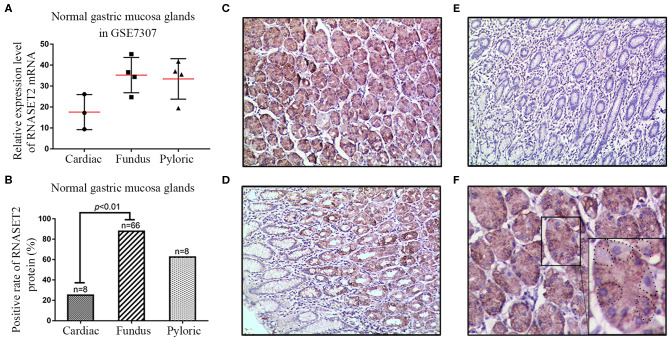
Expression and localization of RNASET2 in different anatomic zones of the stomach. (A) The dataset from GSE7307 showed the relative expression level of RNASET2 mRNA in fundus gland, pyloric gland, and cardiac gland of the normal gastric mucosa tissues. (B) Positive rate of RNASET2 protein in fundus gland, pyloric gland, and cardiac gland of normal gastric mucosa tissues (p < 0.01, Chi-Square and Fisher's exact tests). (C–E) Immunohistochemical staining of RNASET2 protein in fundus gland (C), pyloric gland (D), and cardiac gland (E) of the normal gastric mucosa; DAB staining (brown); nuclear counterstaining (hematoxylin); original magnification, ×100. (F) Representative tissue specimens of RNASET2 protein expression in most of the chief cells and part of the parietal cells; Dotted line areas represent the parietal cells; DAB staining (brown); nuclear counterstaining (hematoxylin); original magnification, ×400.